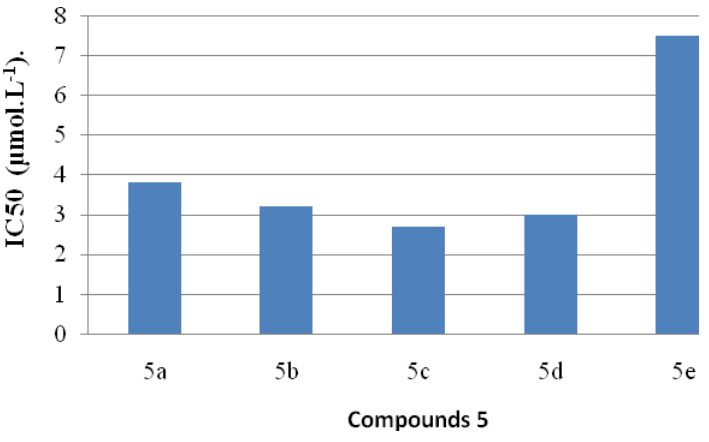
Figure 8. Scavenging ability on ABTS radical of compounds 5